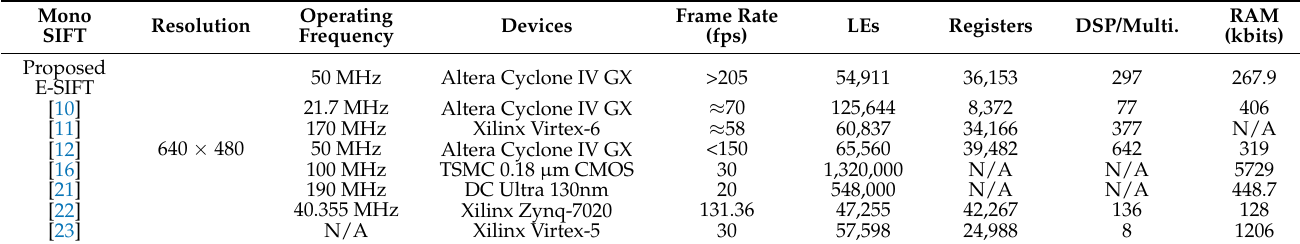
Table 4. Performance comparison of proposed E-SIFT with other published papers .